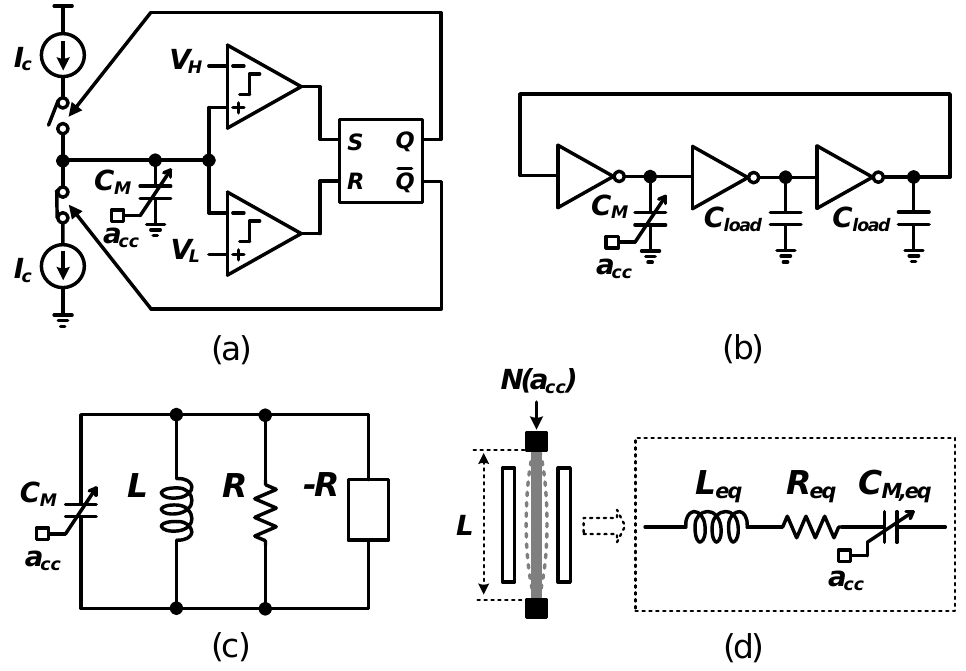
Figure 1. Examples of MEMS controlled oscillators: ( a ) a relaxation-oscillator type [38], ( b ) a ring- oscillator type [26], ( c ) an LC oscillator type, and ( d ) a mechanical resonator and its electrical equivalent model [42,43], where C M denotes the changeable MEMS capacitor controlled by external acceleration a cc